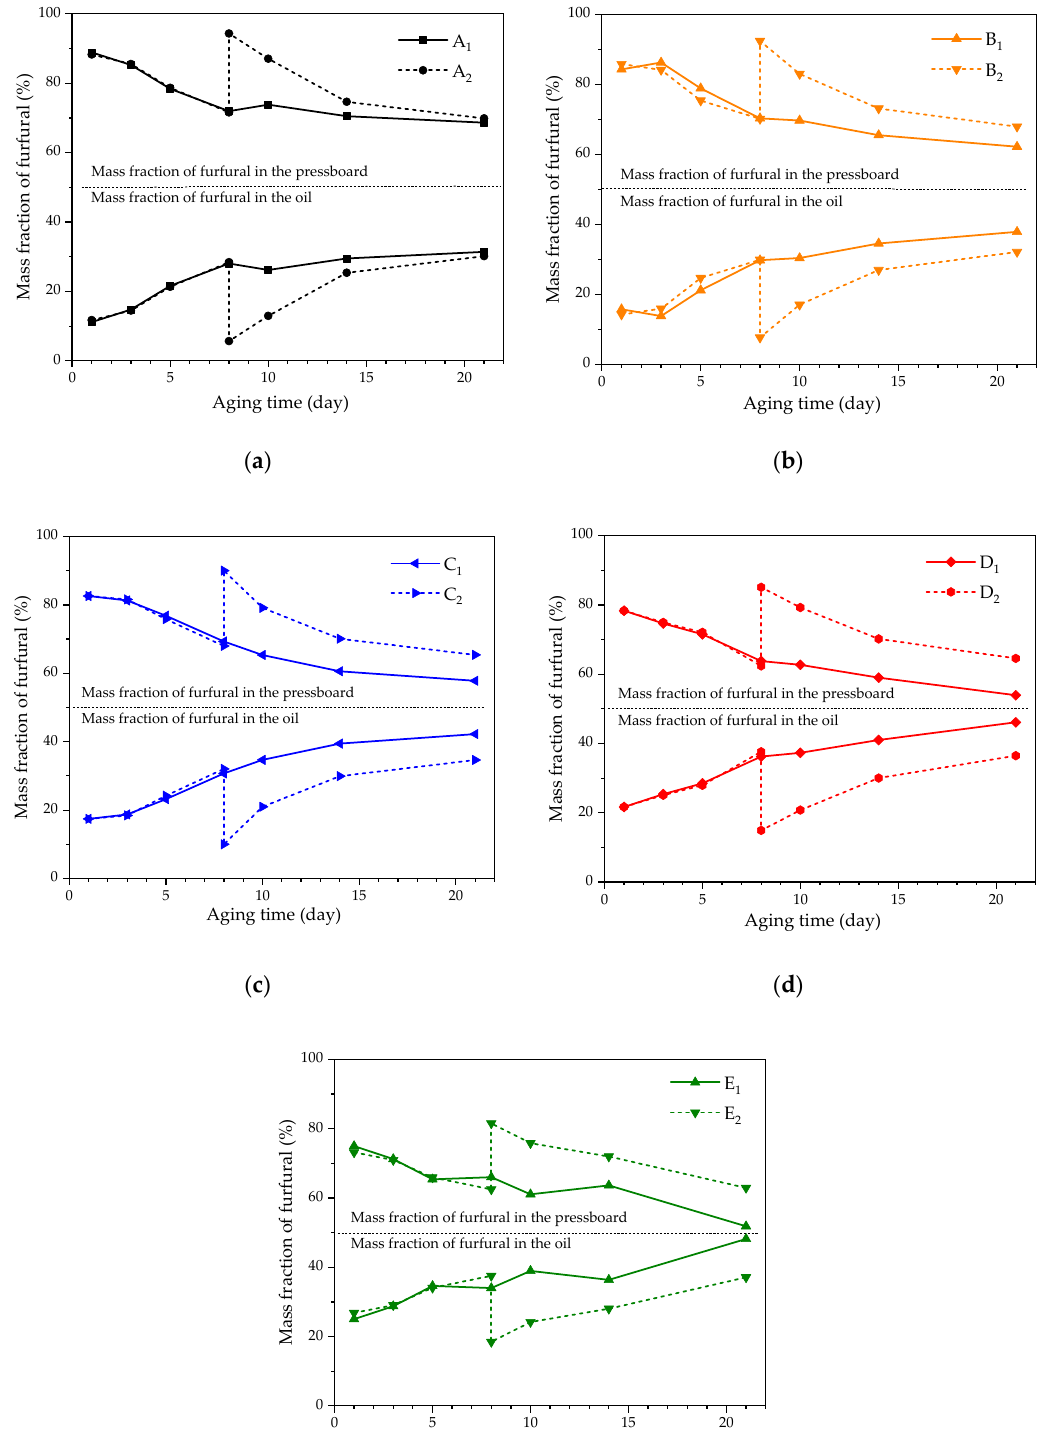
Figure 9. The relationship between furfural mass fraction and aging time after oil replacement. ( a ) E ff ects of oil replacement on the partitioning of furfural in group A. ( b ) E ff ects of oil replacement on the partitioning of furfural in group B. ( c ) E ff ects of oil replacement on the partitioning of furfural in group C. ( d ) E ff ects of oil replacement on the partitioning of furfural in group D. ( e ) E ff ects of oil replacement on the partitioning of furfural in group